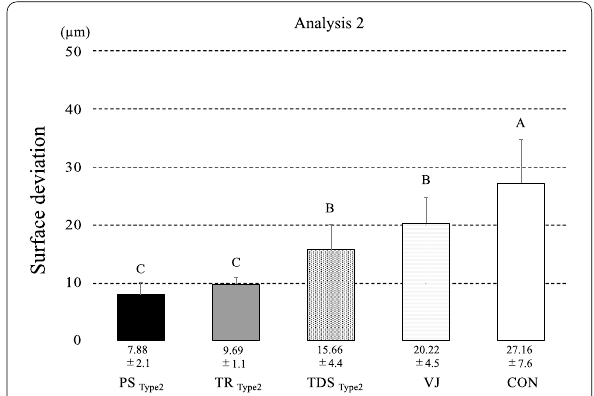
Fig. 6 Average discrepancy in each impression method in analysis 2 (µm). The lines on the bars of the bar graph indicate the standard deviation of the measured discrepancies. PS Primescan, TDS true definition scanner, TR TRIOS3